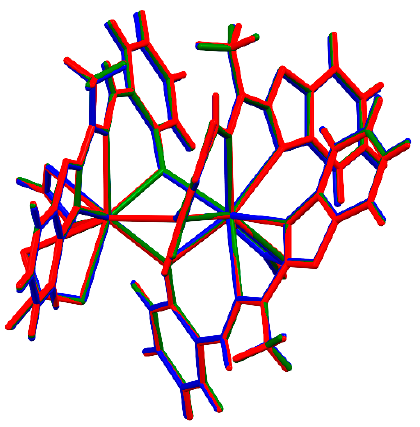
Figure 4. A perspective view of the isostructural complexes of group A